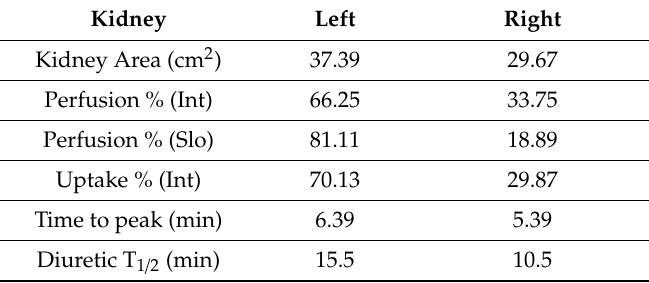
Table 1. MAG-3 (mercaptoacetyltriglycine) diuretic renal scan analysis panel that shows the di ff erential renal function and diuretic T 1 / 2